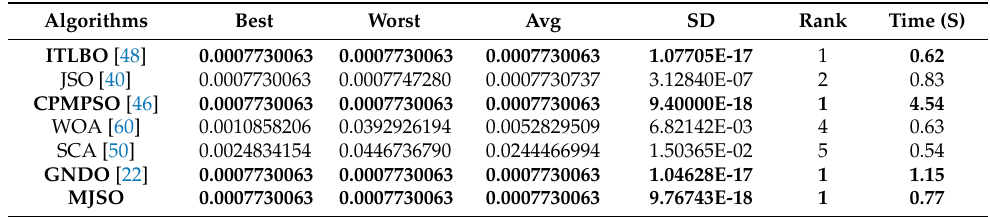
Table 7. Comparison of SDM.